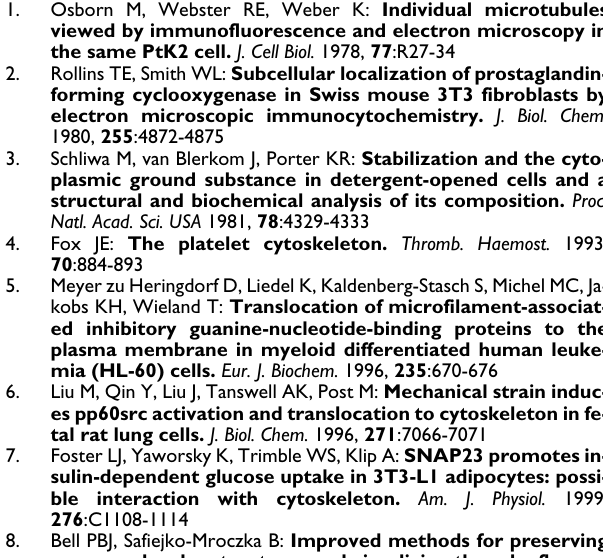
Table 1: Methods of fixation and extraction for immunofluorescent microscopy. Table 2: Comparison of the effects of different methods of prepa- ration on the fluorescence intensity (Flu. int.), pattern of fluores- cent labeling of stress fiber (SF) and morphological preservation of microextensions (ME) by TRITC-phalloidin (phalloidin) and monoclonal anti- β -actin antibody (mAb- β -actin) and pattern of tu- bulin staining by β -tubulin antibody (mAb- β -tubulin). Morphological preservation of the cells attached on coverslips (Morph.) and of mi- croextensions (ME) were also examined by SEM before and after treatment for fluorescence microscopy. The range is from excel- lent (+++++) to very poor (0).